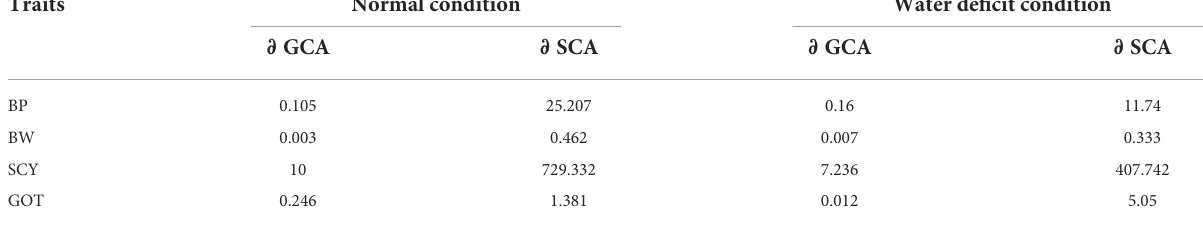
TABLE 6 Estimation of genetic components of variation under normal and drought condition.